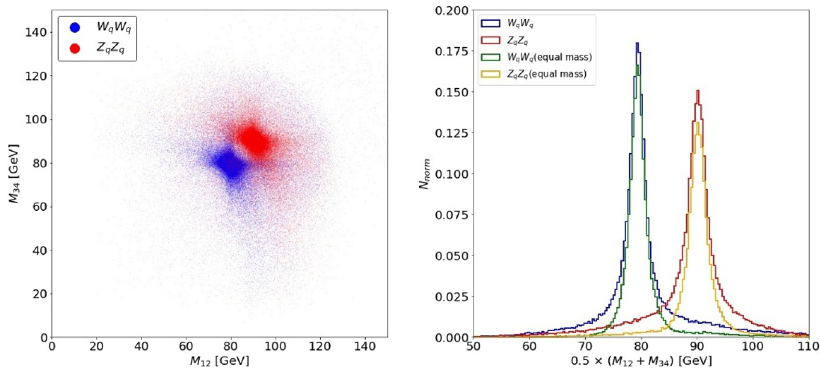
Figure 9 . Distributions of the reconstructed W q W q and Z q Z q events at the m 12 (cid:0) m 34 plane (left) and w.r.t. ( m 12 + m 34 ) = 2 (right), with a perfect detector.